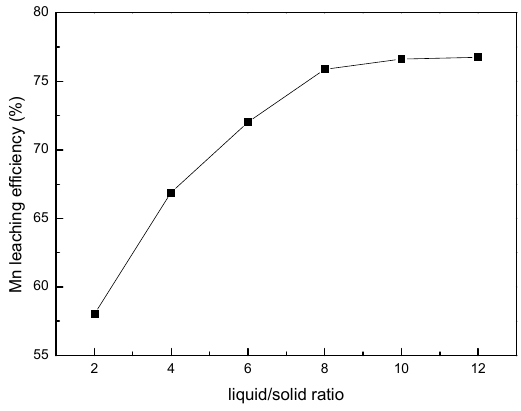
Figure 3. The effect of the liquid/solid ratio on the manganese leaching efficiency.